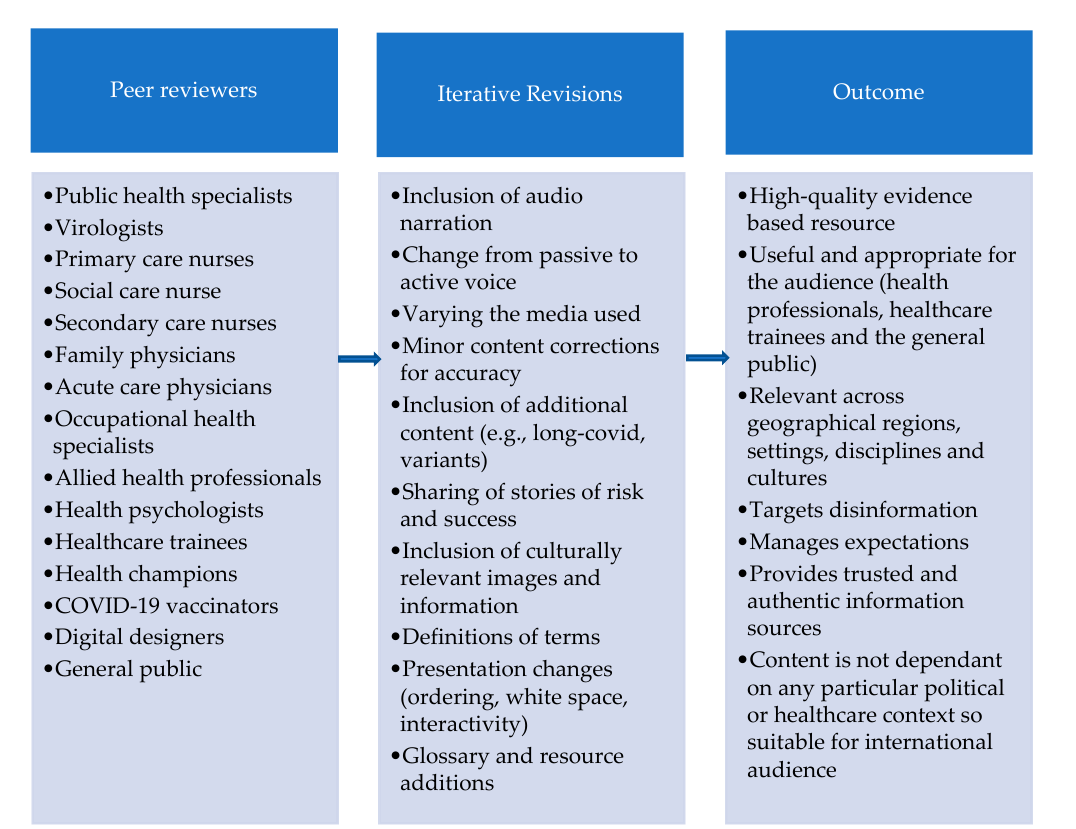
Figure 4. Co-design through expert and lay peer review.